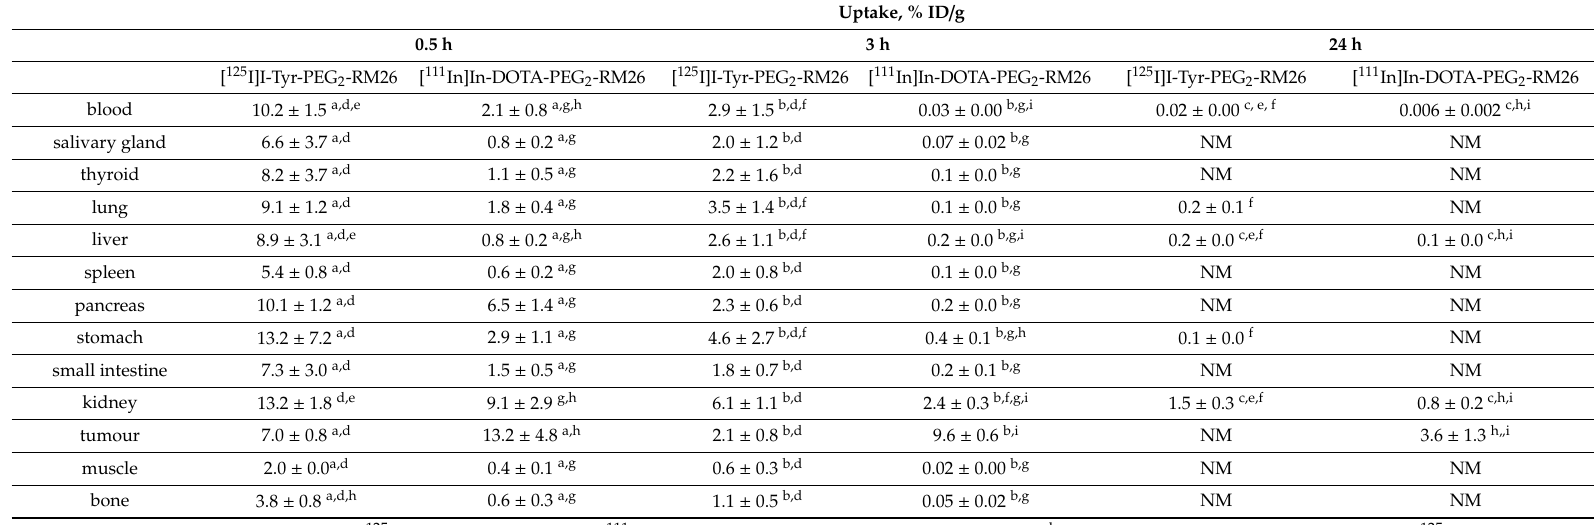
Table 1. Biodistribution of [ 125 I]I-Tyr-PEG 2 -RM26 and [ 111 In]In-DOTA-PEG 2 -RM26 in GRPR-expressing PC-3 tumour xenografted female BALB / C nu / nu mice at three time points (total injected mass of 40 pmol). Data are presented as the mean percentage of injected dose per gram tissue (% ID / g; Mean ± SD; n = 4), NM stands for